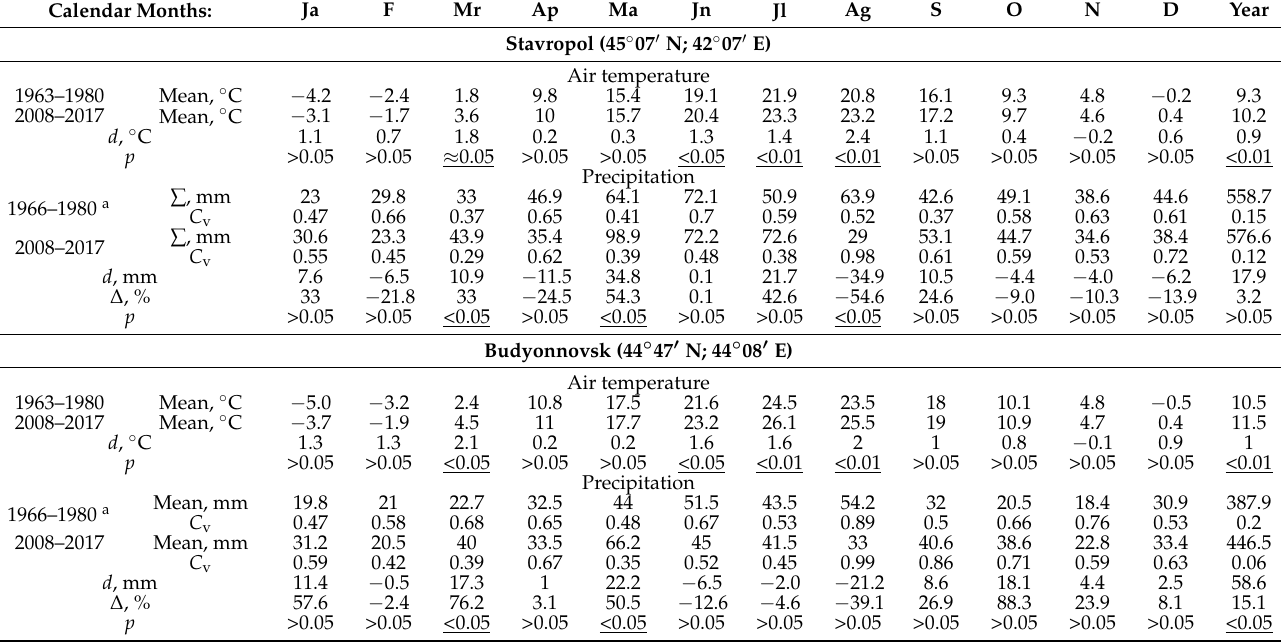
Table 3. Changes in monthly/annual air temperature and precipitation at meteorological stations in Stavropol and Budyonnovsk (the Stavropol Krai, SW Russia, see Figure 1) between 1963–1980 and